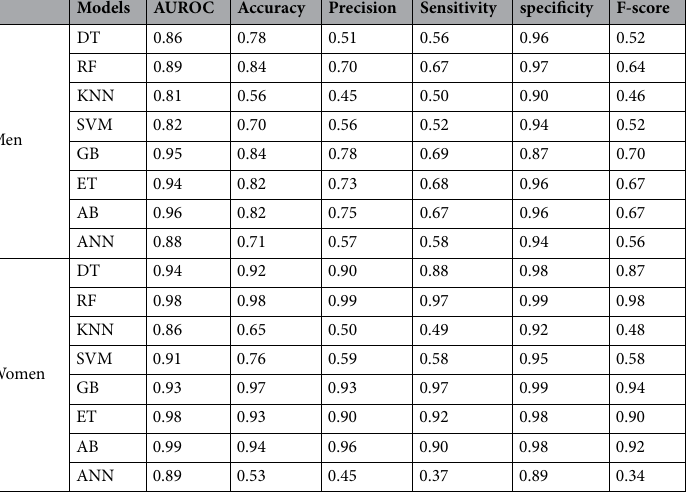
and finally, using multilayer perceptron classification, individuals were classified into three categories of normal, osteopenia and osteoporosis. In 2021, Wang et al. 34 studied 1559 Chinese women over the age of 20 to develop an ANN model using age and weight as input for prediction of osteoporosis, achieving an AUROC of 0.78. A study in 2021 by Yang et al. 3 entitled Development of Machine Learning Models for Prediction of Osteoporosis from Clinical Health Examination Data used a sample population of 3053 Taiwanese men and 2929 women; in this research, the best AUROC of 0.843 and 0.811 in men and in women, respectively was achieved with the RF algorithm for predicting osteoporosis. The following input characteristics were used: medical history of diabetes and hypertension, history of smoking and alcohol consumption liver function, thyroid function, lipid profile, blood protein content, electrolytes, hematological profile, renal function, and for women, history of obstetrics and gynecology were also included. Among male patients, secondary causes such as alcohol abuse, steroid therapy, and other metabolic disorders account for up to 65% of cases of osteoporosis 3 . In contrast, the prevalence of secondary osteoporosis is much lower in women than in men 35 . In women, estrogen deficiency after menopause and osteoporosis is one of the main causes of osteoporosis 36 . In the present study, for men and women, due to differences in cause and baseline characteristics, prediction algorithms were trained separately,